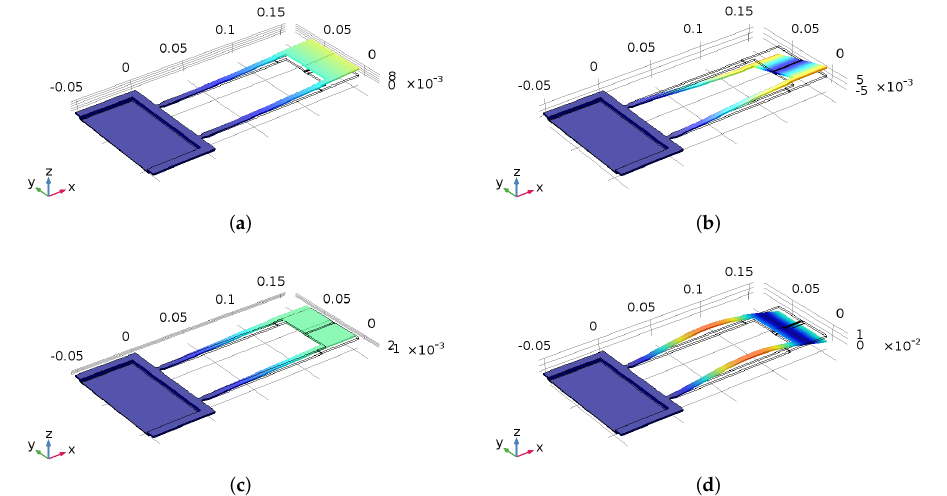
Figure 2. The first four modes of the gas sensor. ( a ) 1st out-of-plane bending; ( b ) 1st torsional mode;